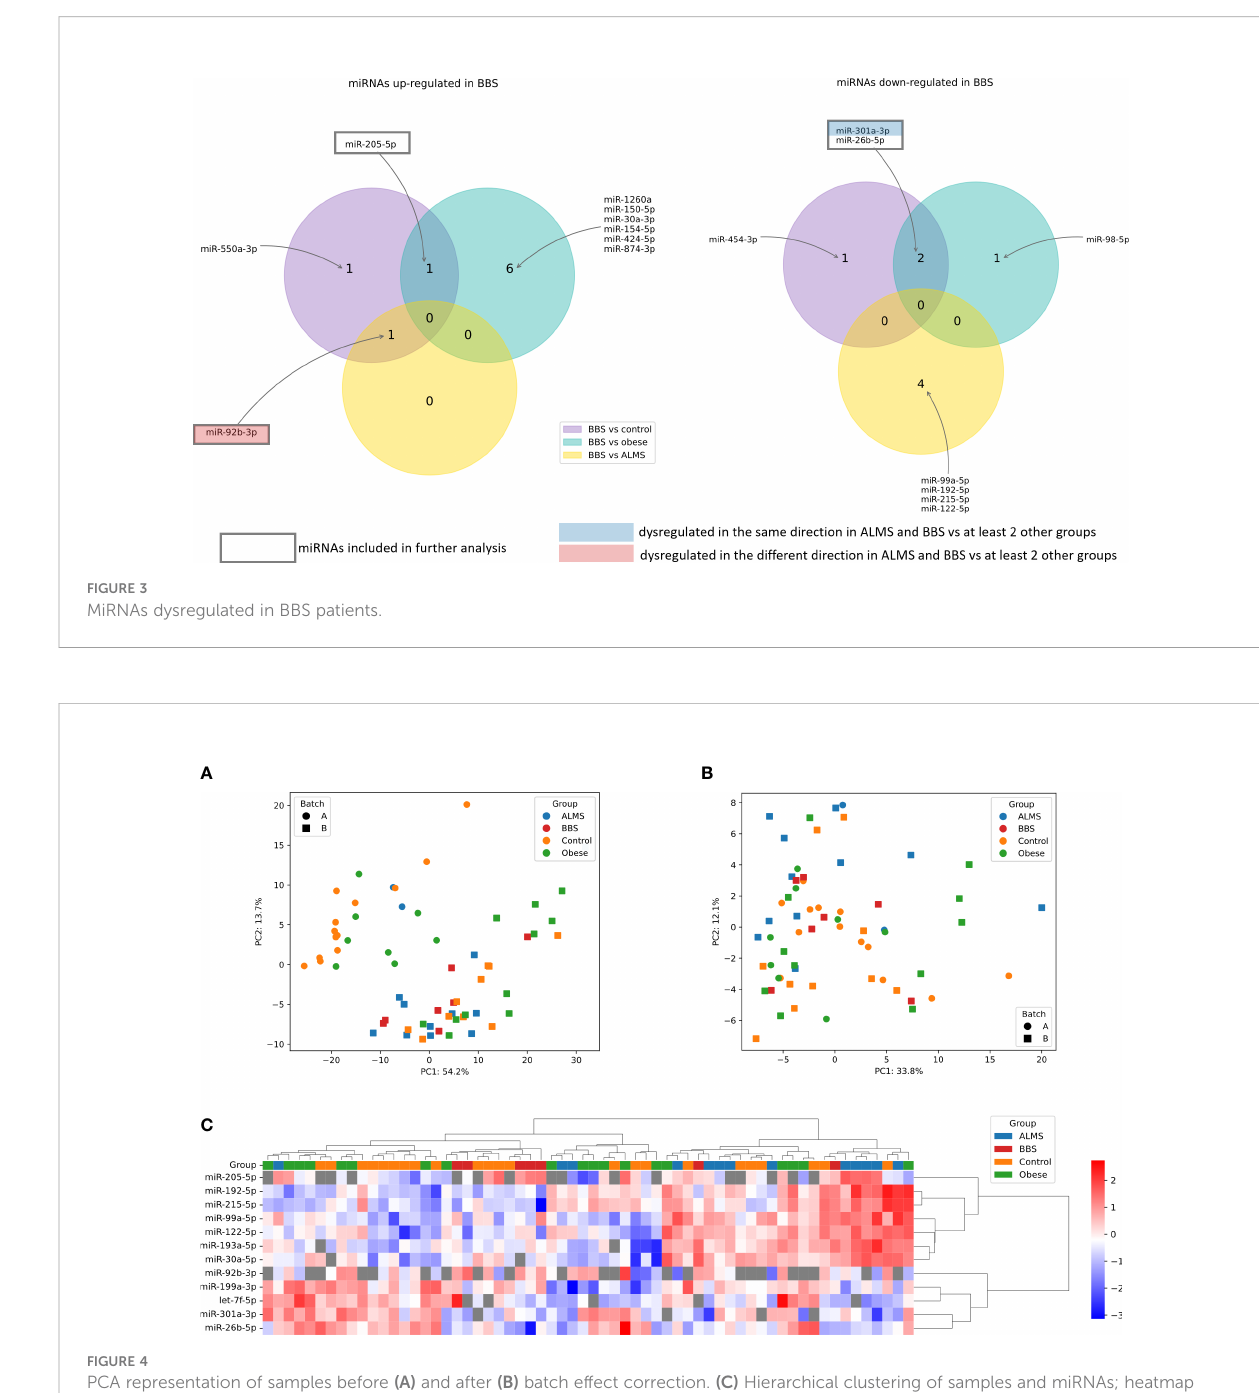
FIGURE 4 PCA representation of samples before (A) and after (B) batch effect correction. (C) Hierarchical clustering of samples and miRNAs; heatmap shows - D Ct, scaled per miRNA; distance measure: Euclidean for samples, 1 – correlation coef fi cient for miRNAs, linkage method: Ward for both dendrograms; undetects are marked with